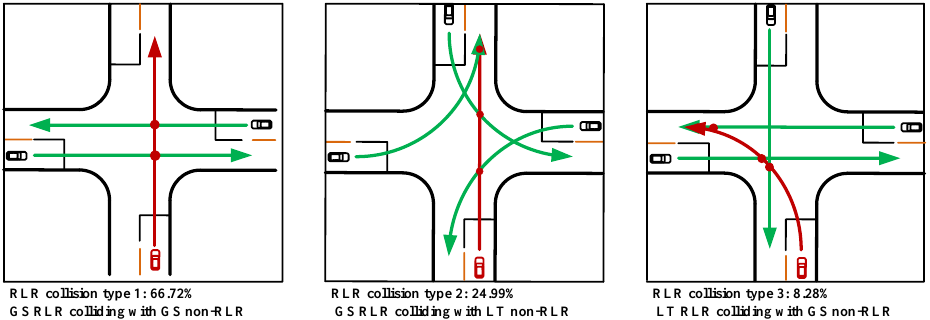
Figure 1. The three red-light-running (RLR) crash types obtained from the general estimates system (GES) database. Note: the green line indicates the approaching path of non-RLR vehicle; the red line indicates the approaching path of RLR vehicle. GS represents vehicle's go straight movement and LT represents vehicle's left-turning movement.